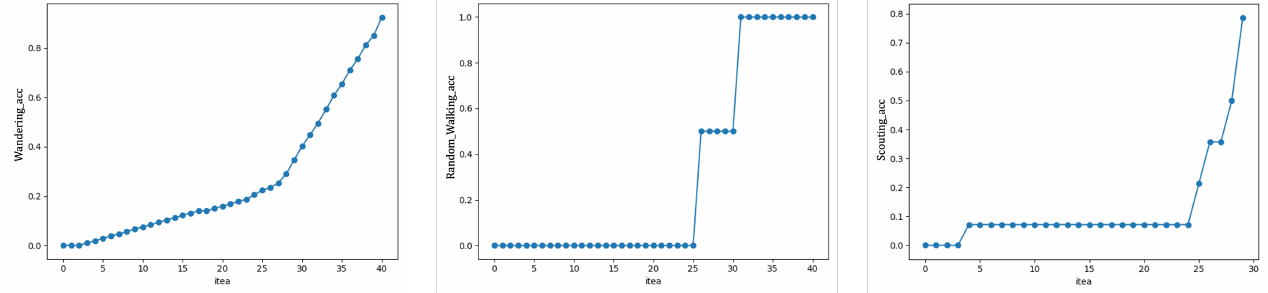
Figure 7. Accuracy comparisons by different thresholds (cid:101)